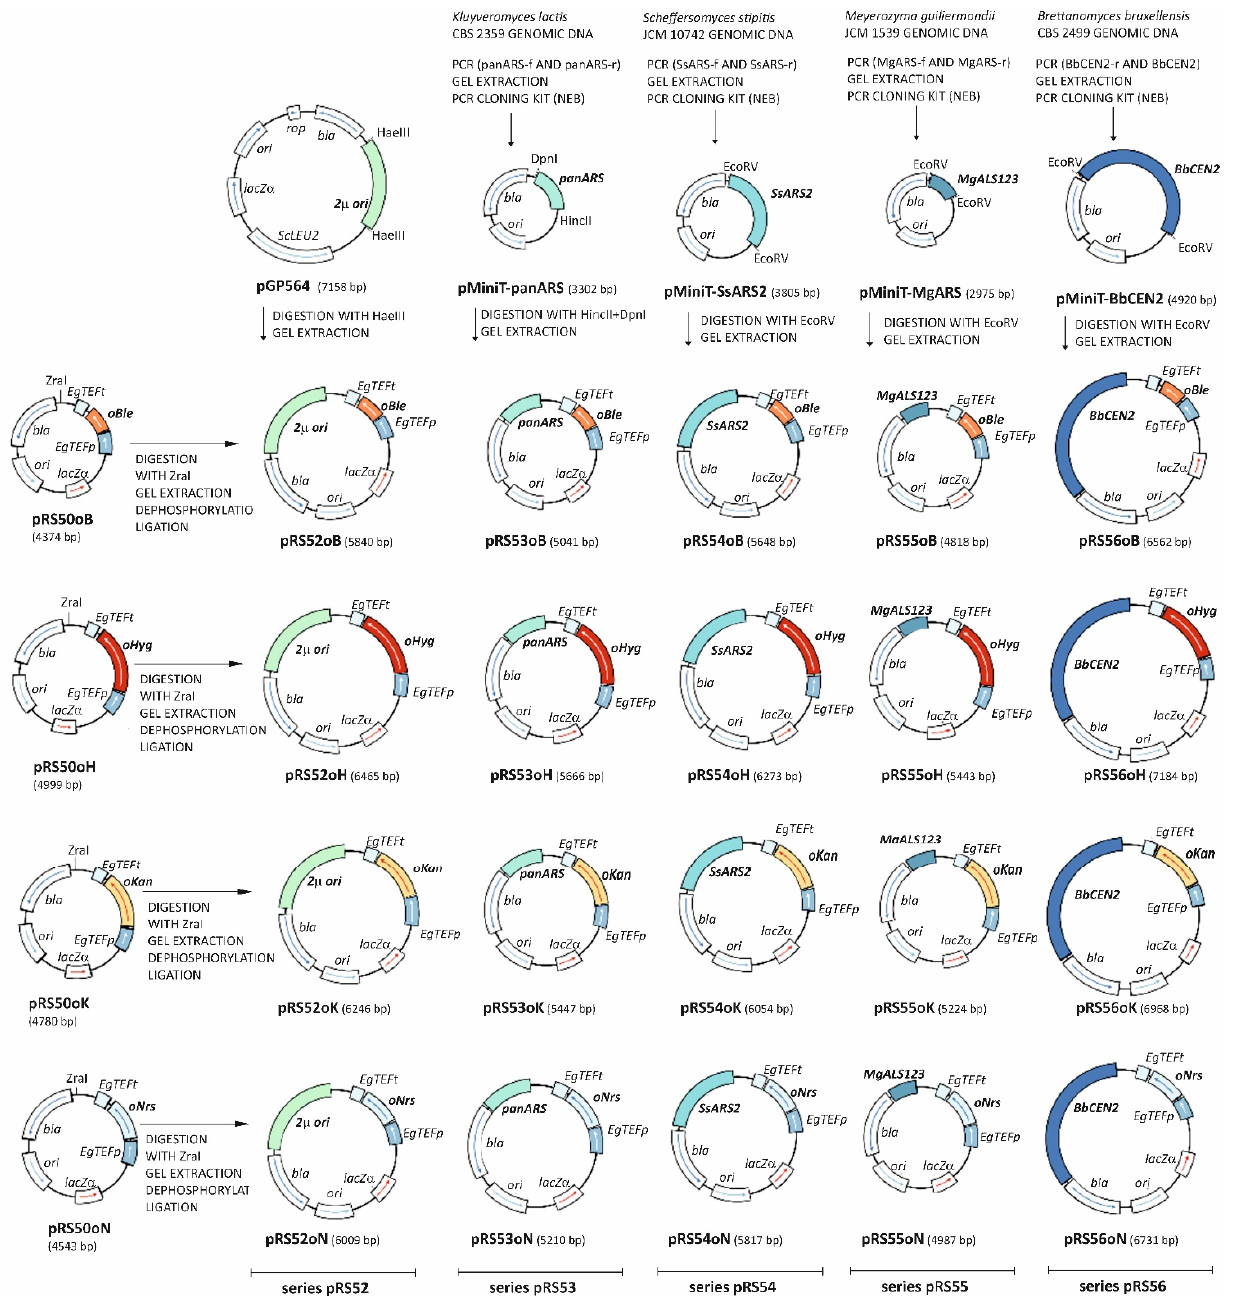
Figure 2. Construction of the plasmid series pRS52, pRS53, pRS54, pRS55, and pRS56 (replicative plasmids, each carrying one yeast replication origin) with a detailed list of intermediate cloning steps and relevant restriction sites. 2µ ori, panARS, SsARS2, MgALS123, BbCEN2 = yeast replication origins, ScLEU2 = LEU2 gene from Saccharomyces cerevisiae , rop = gene encoding Rop protein in E. coli . Other labels are identical to those in Figure 1.